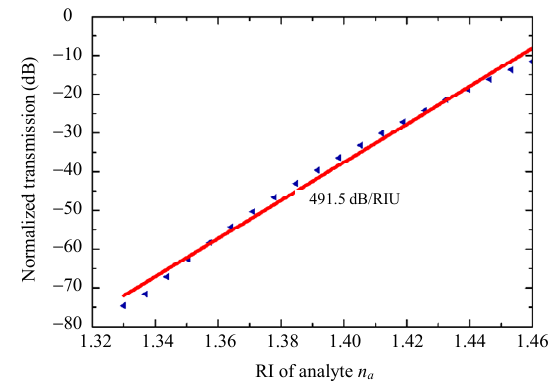
Fig. 10 Normalized transmission changes with RI of the